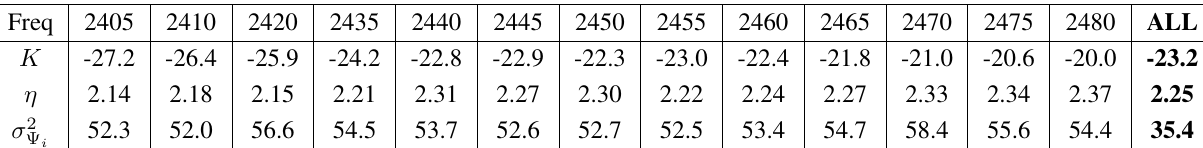
Table 1. Channel parameters estimated for every considered ZigBee channel and for all channels.